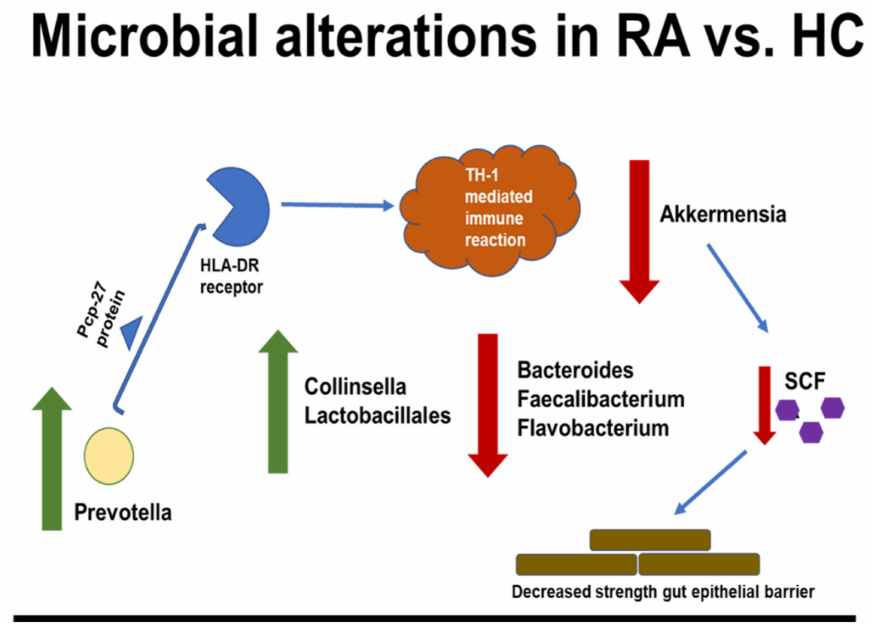
Figure 1. Microbial dysbiosis and gut short-chain fatty acid (SCFA) dysregulation lead to immune activation and inflammation in